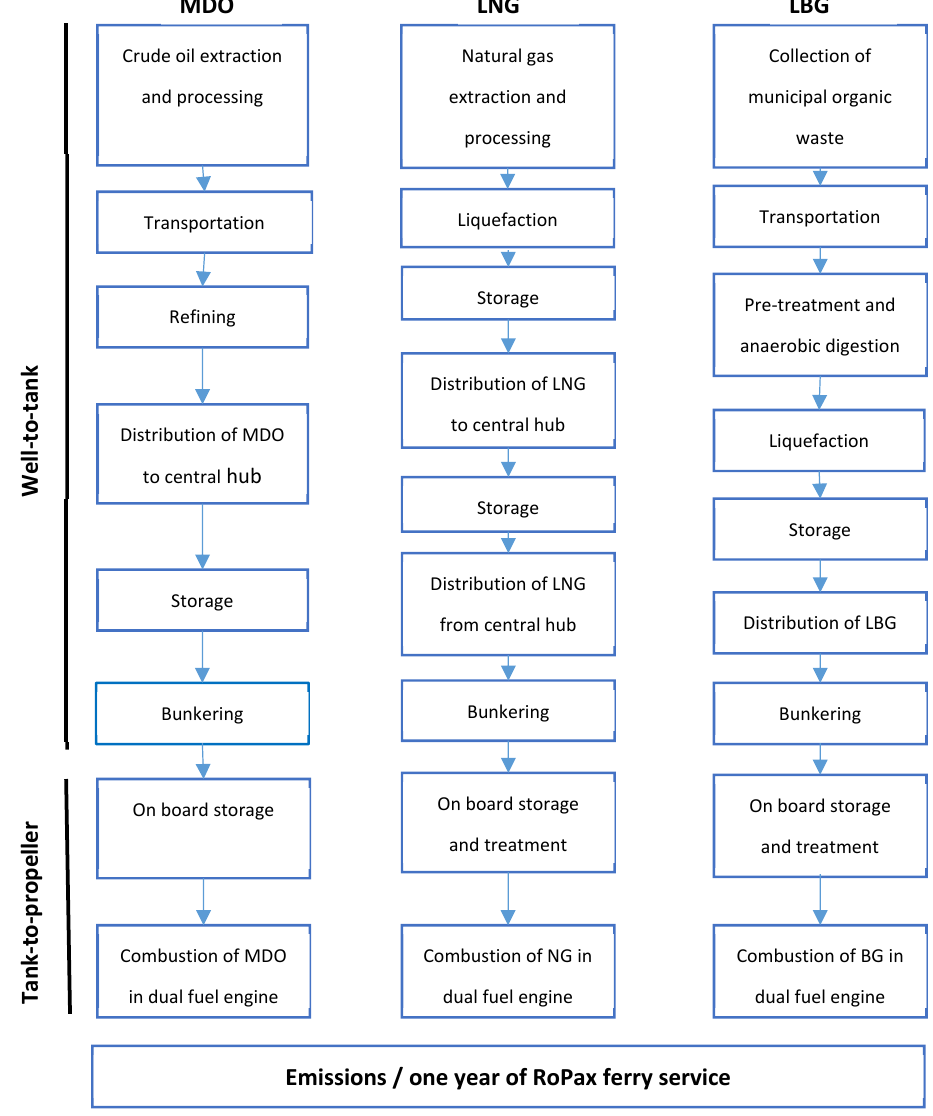
Figure 1. Flowchart of studied fuels and included processes.